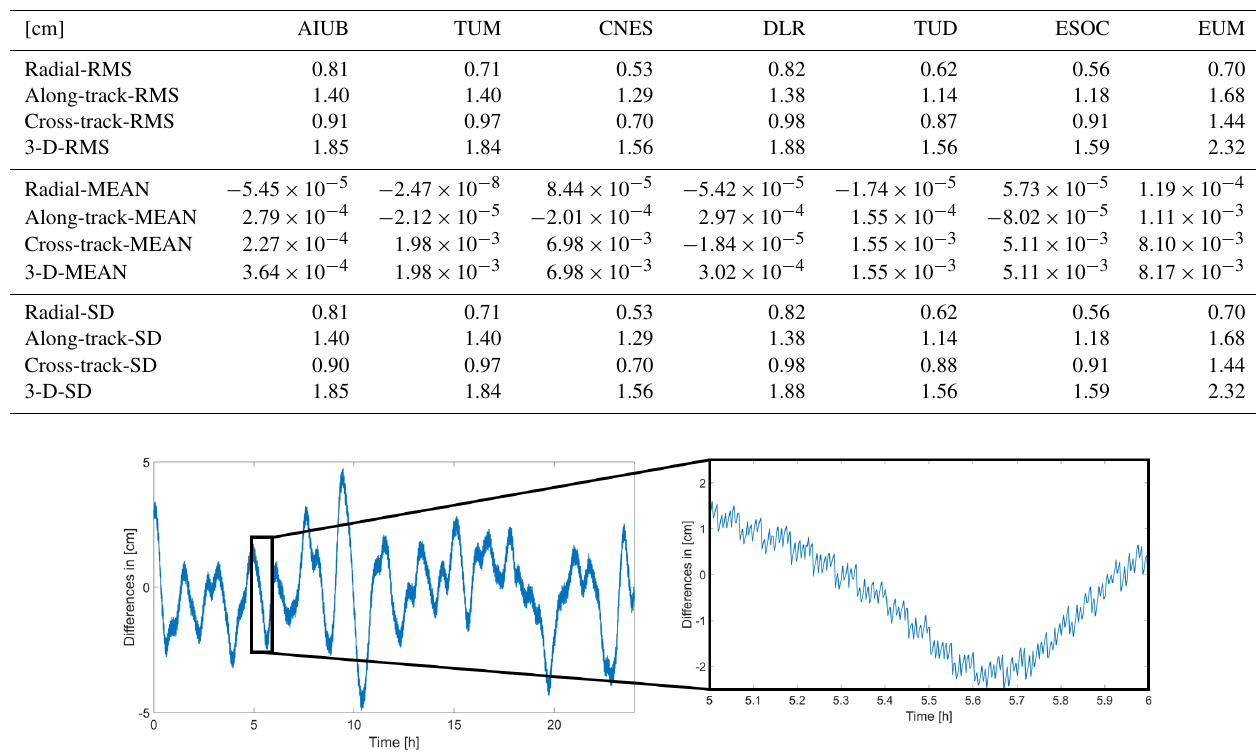
Figure 2. Epoch problem revealed by the comparison of AIUB versus CPOD solution in the along-track direction.